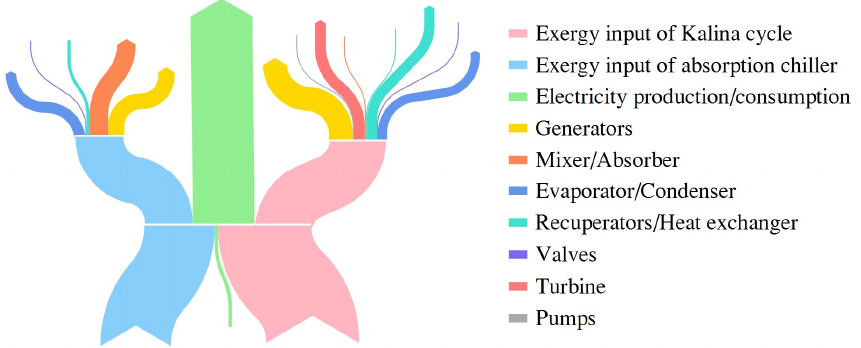
Figure 6. Sankey diagram of the integrated